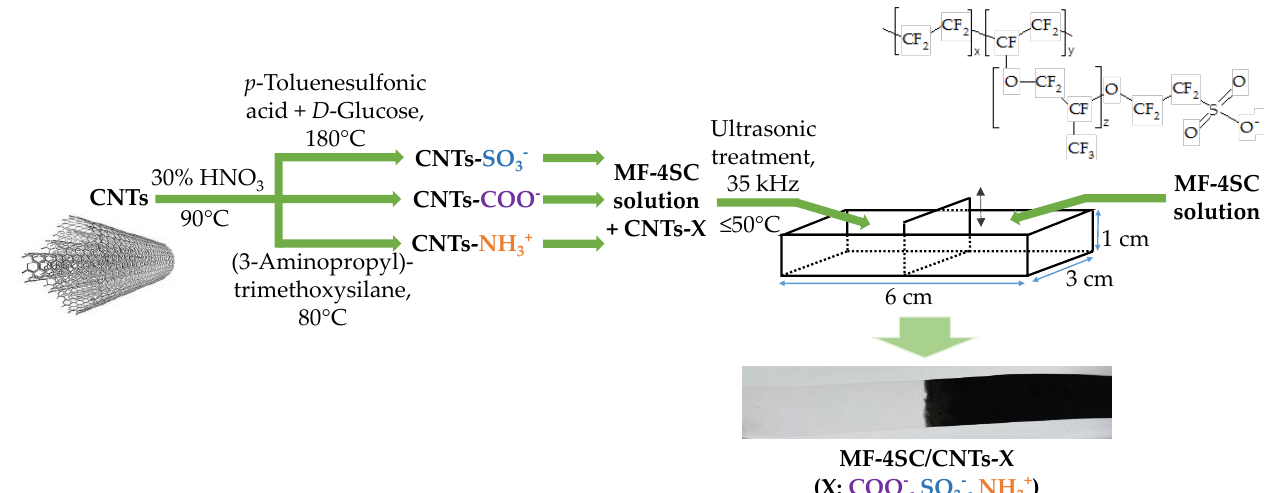
Figure 3. The scheme of preparation of the MF-4SC/CNTs-X hybrid membranes. A membrane with gradient distribution of CNTs along the length is shown.